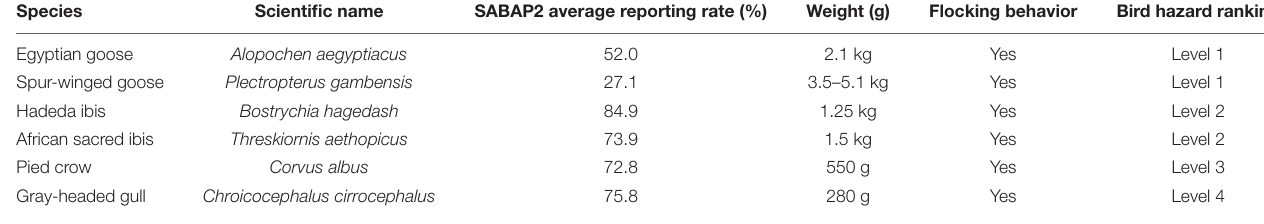
TABLE 3 | The SABAP2 reporting rate, known to occur at the OR Tambo International Airport. Species